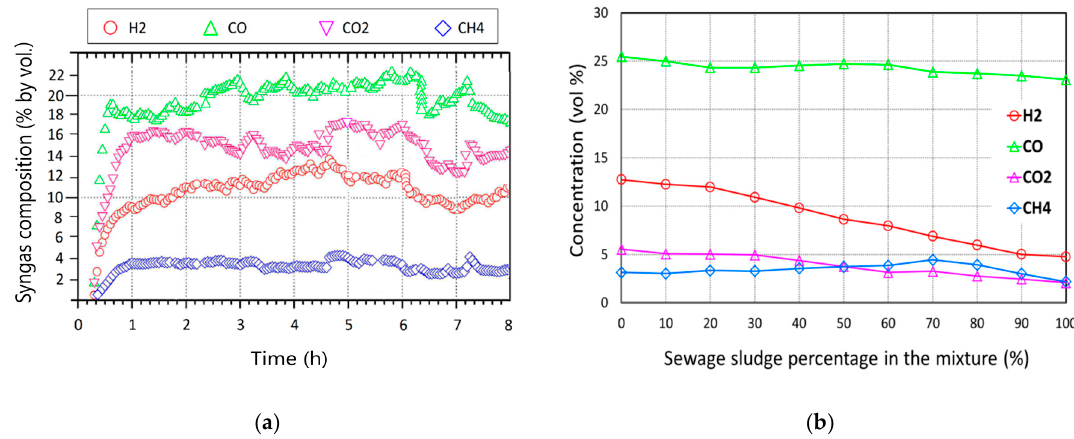
Figure 7. ( a ) Real history for syngas composition during gasification of Virginia Mallow assisted dried sewage sludge in 50/50% by mass; ( b ) modeled syngas combustible content vs. percentage of sewage sludge.